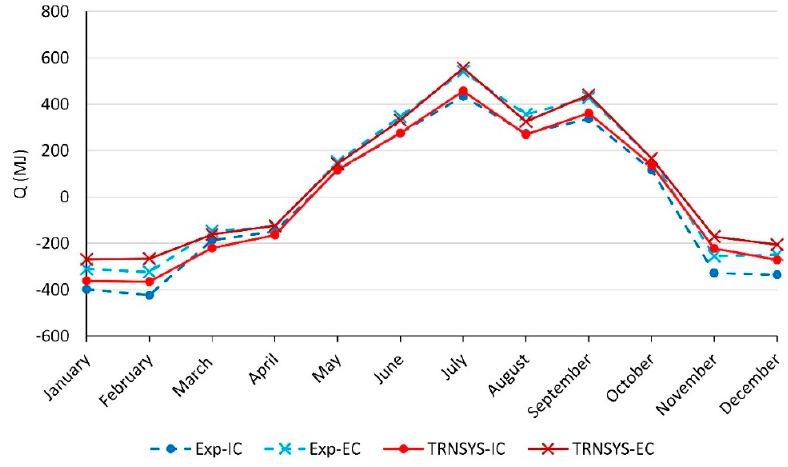
Figure 9. Thermal load simulation results of the complete GSHP system model.